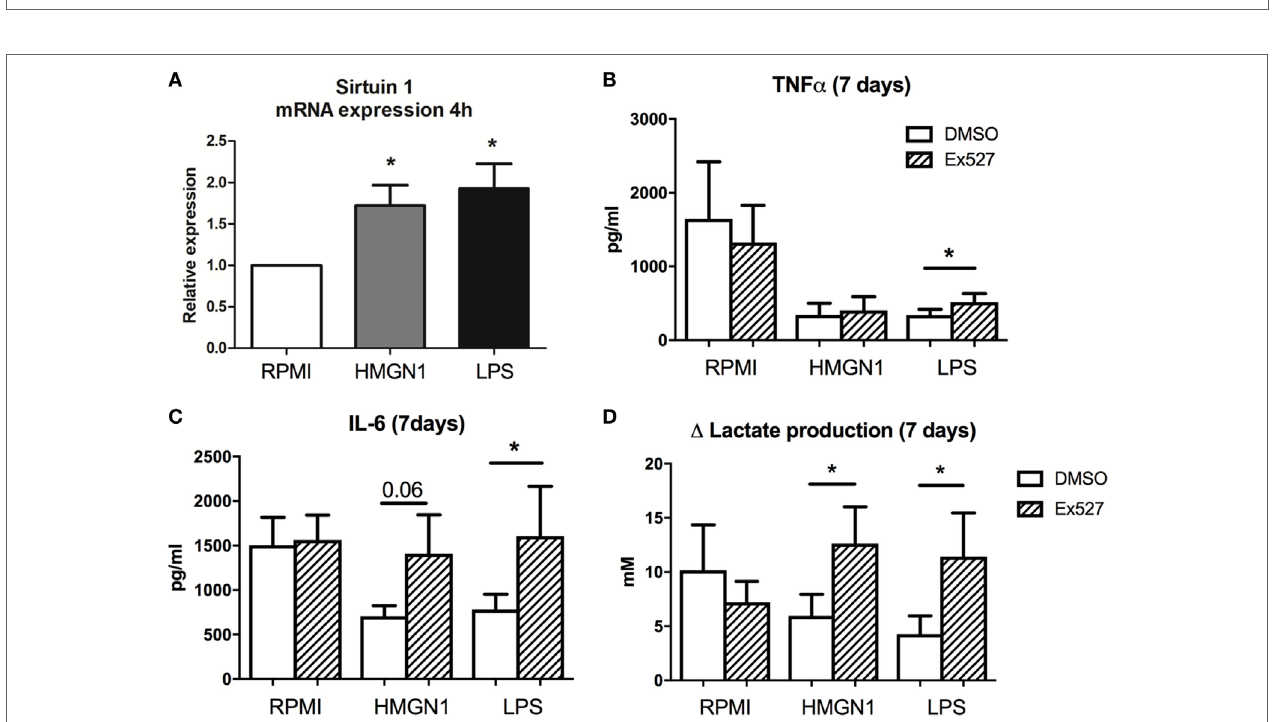
FigUre 7 | Inhibition of Sirtuin-1 restores cytokine and lactate production. Human peripheral blood mononuclear cells (PBMCs) were incubated with high-mobility group nucleosome-binding protein 1 (HMGN1) or lipopolysaccharide (LPS) for 4 h, then (a) mRNA was isolated and sirtuin-1 expression was determined by RT-PCR, showing an upregulation of sirtuin-1 for both stimuli. Human PBMCs were preincubated for 1 h with EX527 (sirtuin-1 inhibitor) before LPS or recombinant HMGN1 were added for 24 h. Then stimuli were washed away and cells rested in RPMI with 10% serum for an additional 6 days before they were restimulated with RPMI or LPS. (B) IL-6, (c) TNF, and (D) lactate production were assessed ( n = 4–5, * p <